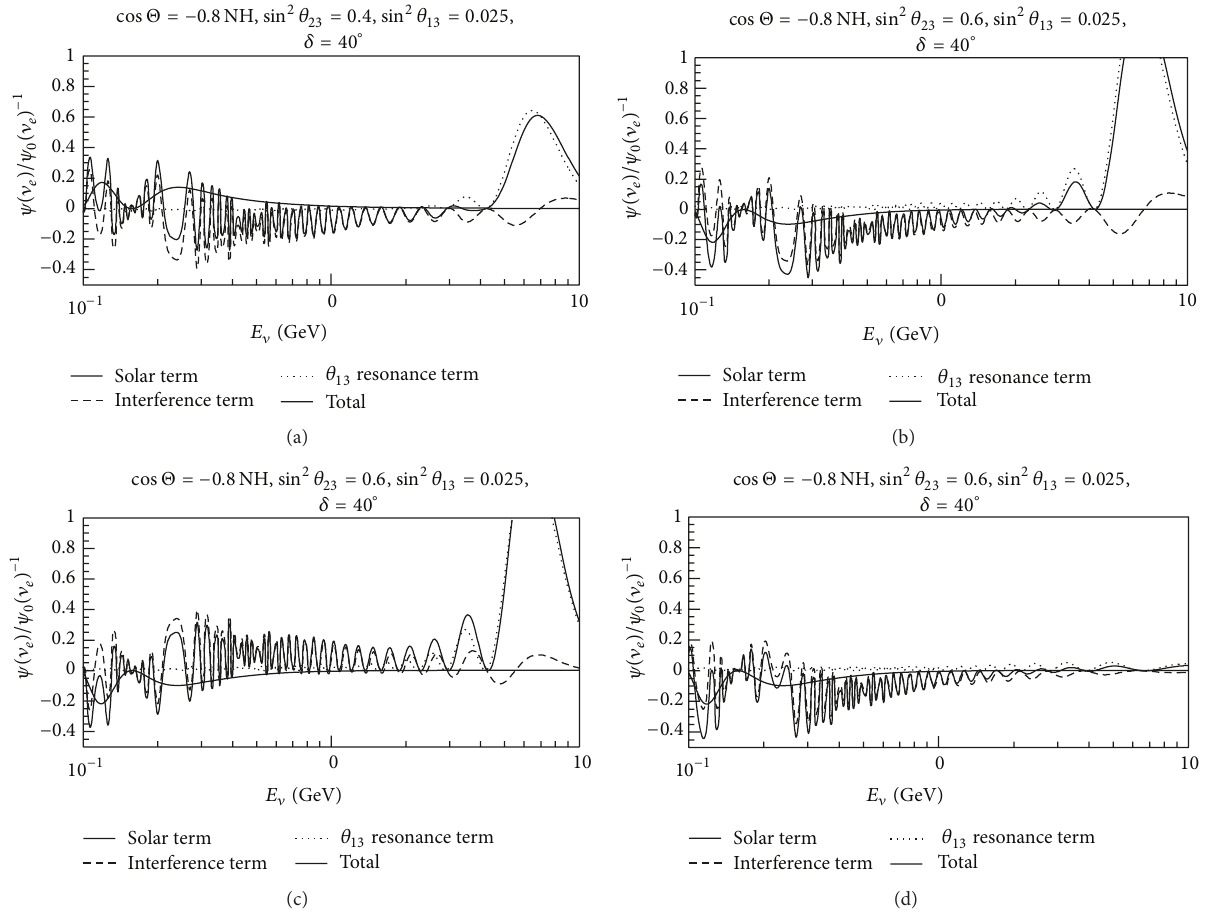
Figure17:Oscillated 𝜈 𝑒 fluxrelativetothenonoscillatedfluxasafunctionofneutrinoenergyfortheupward-goingneutrinoswithzenithangle cos Θ 𝜈 = −0.8 . 𝜈 𝑒 isnotincludedintheplots.Thinsolidlines,dashedlines,anddottedlinescorrespondtothesolarterm,theinterferenceterm, and the 𝜃 13 resonance term, respectively. Thick solid lines are total fluxes. Parameters are set as ( sin 2 𝜃 12 ,sin 2 𝜃 13 ,sin 2 𝜃 23 , 𝛿 , Δ𝑚 2 21 , Δ𝑚 2 32 ) = (0.31 , 0.025 , 0.6 , 40 ∘ , 7.6 × 10 −5 eV 2 , +2.4 × 10 −3 eV 2 ) unless otherwise noted. The mass hierarchy is normal in (a), (b), and (c); so 𝜃 (MSW) effect appears in 5–10 GeV neutrino energy region. For the inverted hierarchy case in (d), the MSW effect should appear in the 𝜈 𝑒 flux, which is not shown in the plot. The 𝜃 23 octant effect can be seen by comparing (a) (sin 2 𝜃 23 = 0.4 ) and (b) (sin 2 𝜃 23 = 0.6 ). 𝛿 value is changed to 220 ∘ in (c) to be compared with 40 ∘ in